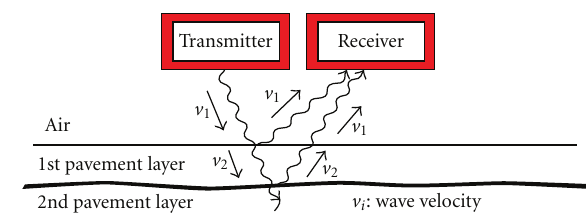
Figure 9: Pulse propagation principle.